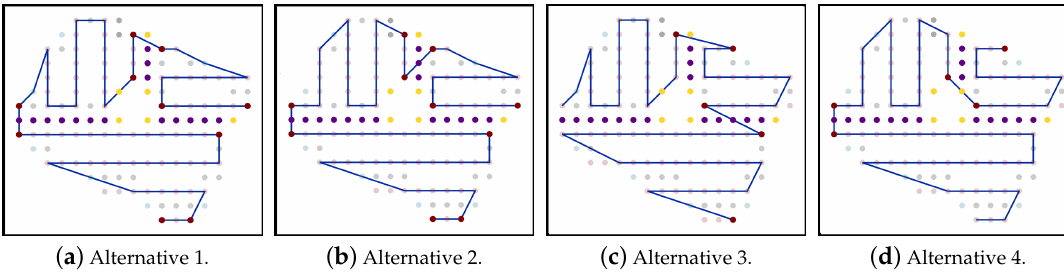
Figure 19. The paths generated by using each of the